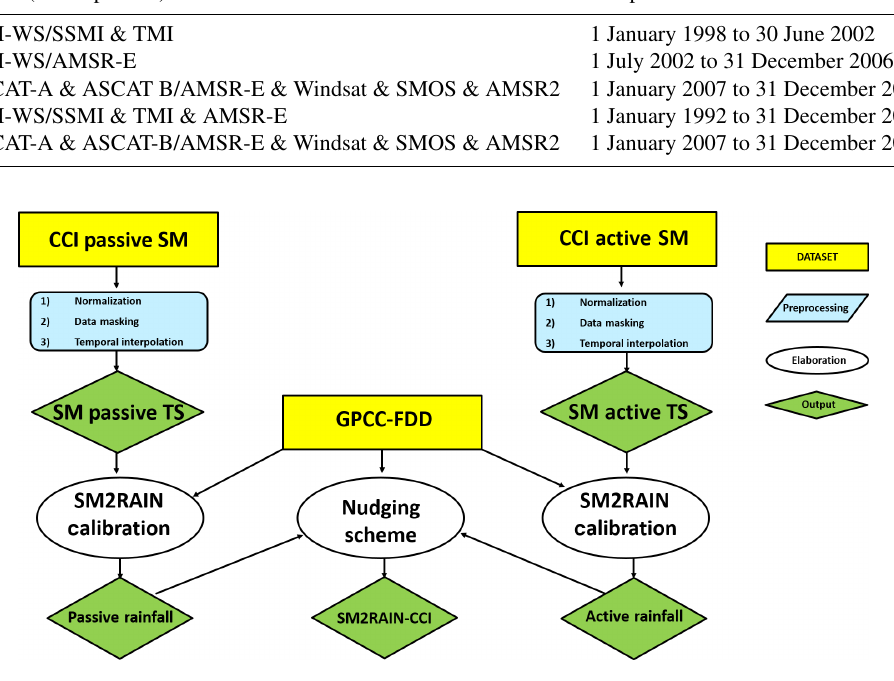
Figure 2. Analysis